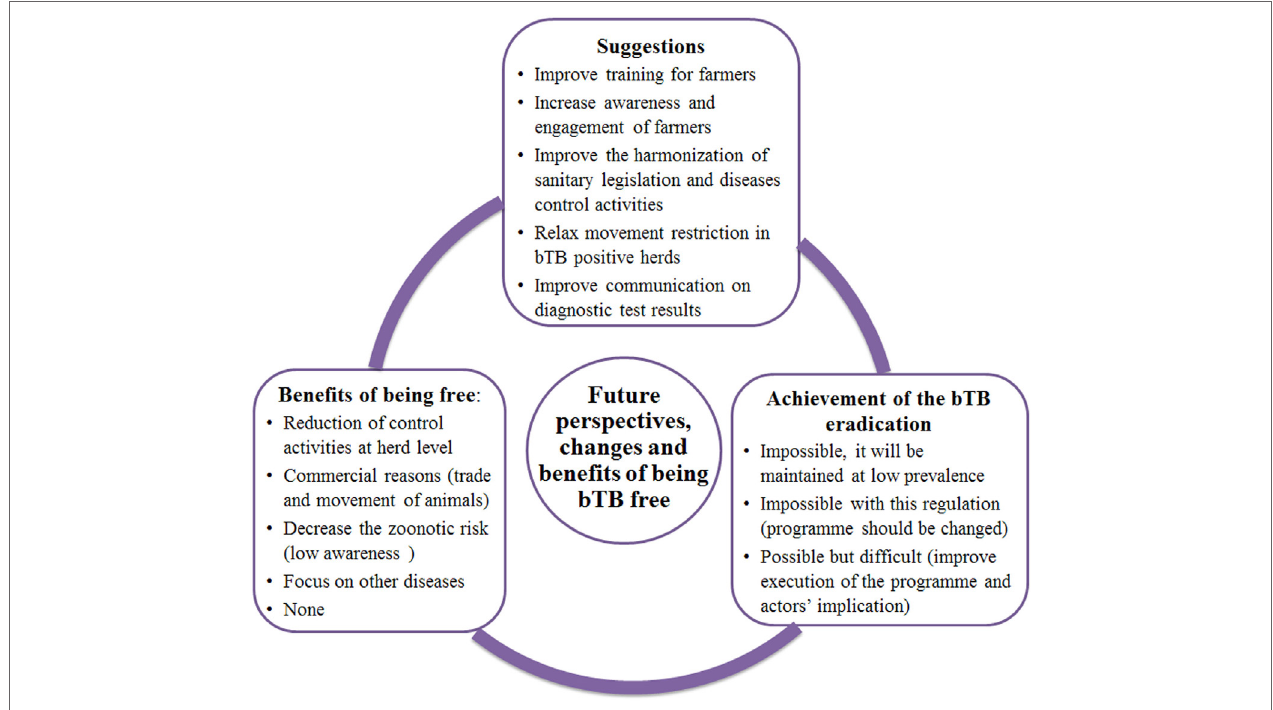
FigUre 5 | Schematic representations of the main themes emerged from exploratory interviews as “Future perspectives,” “Proposed changes to the bovine tuberculosis (bTB) eradication program,” and “Benefits of being bTB free”; results for Andalusia and Catalonia are presented